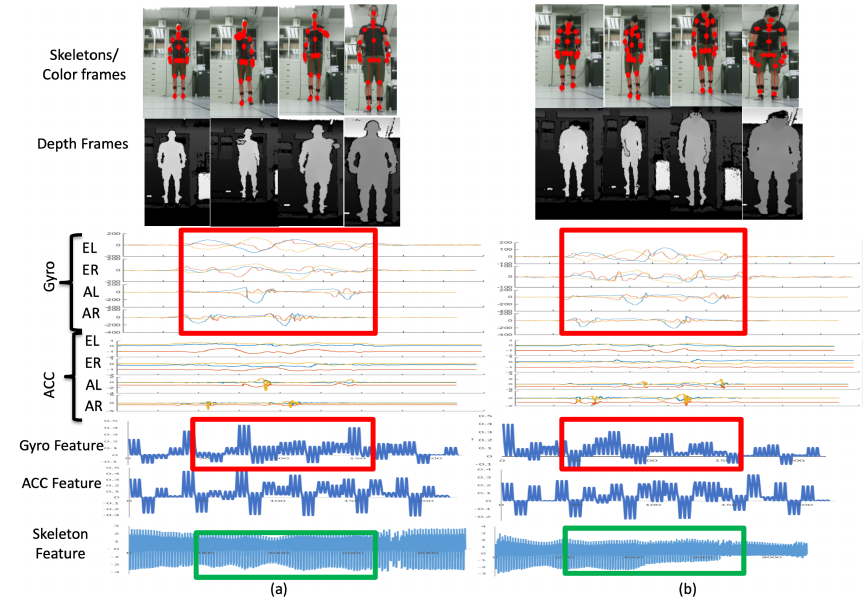
Figure 18. Results from AW to NW; similar gyro features, dissimilar skeletal